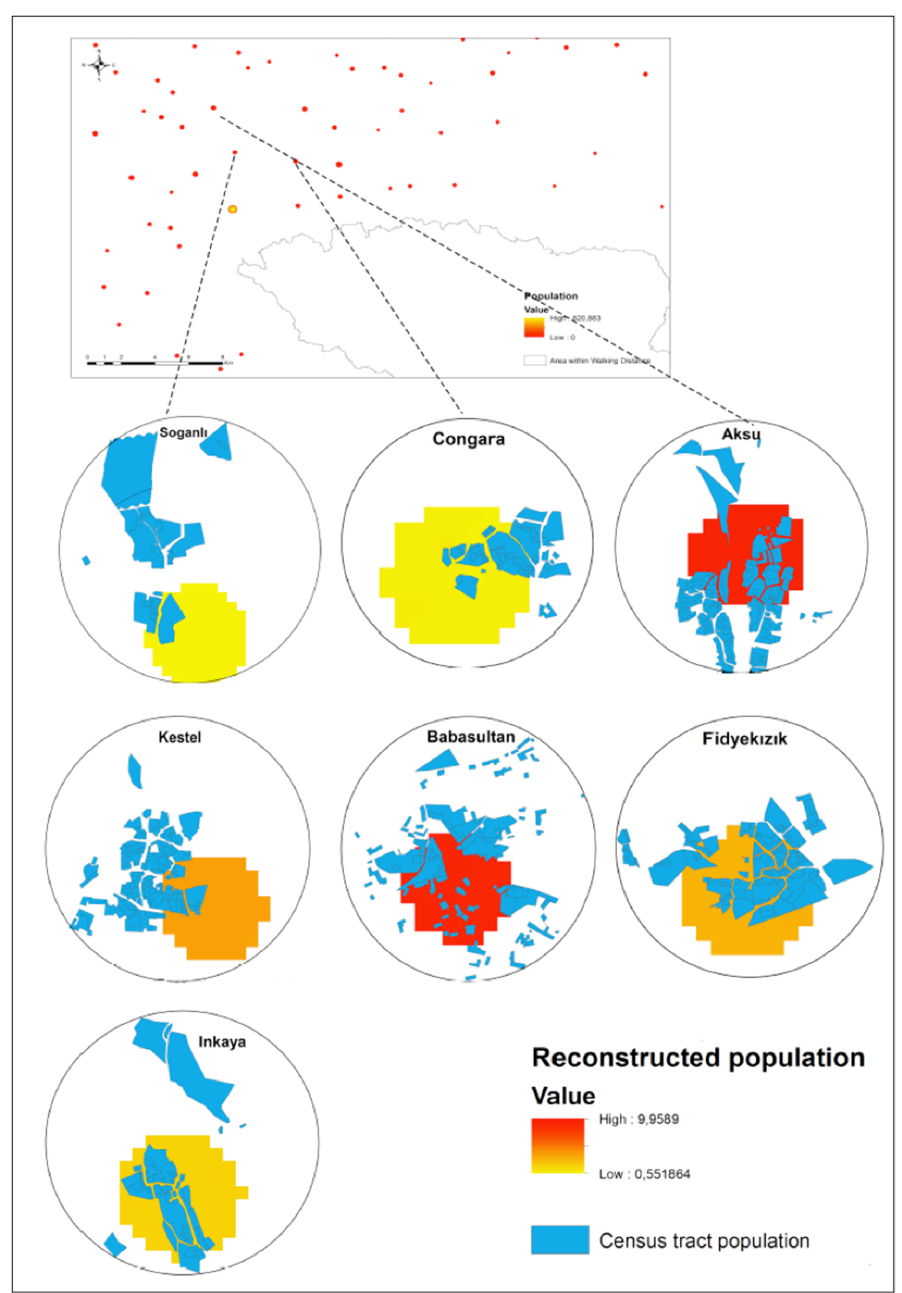
Figure 8. Comparison of observed and simulated residential cover maps for the sampled villages.